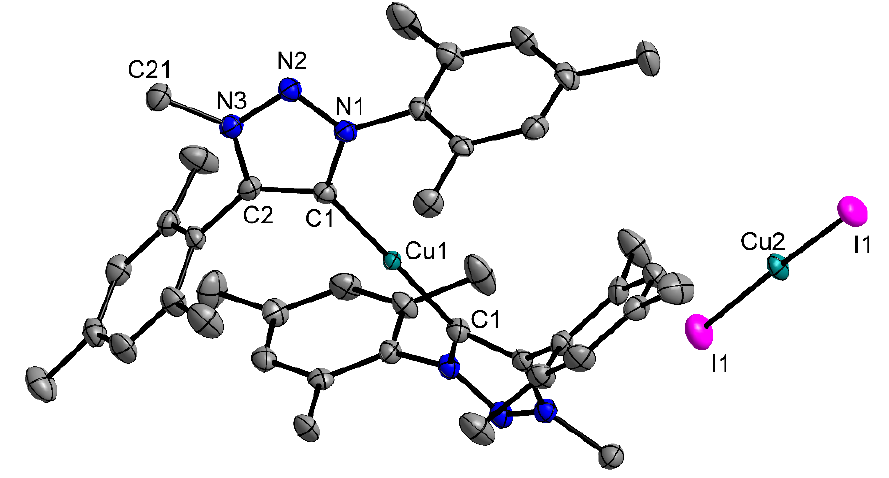
Figure 3. ORTEP-Plot of 2á . Hydrogen atoms are omitted for clarity. Ellipsoids are shown at 50% probability